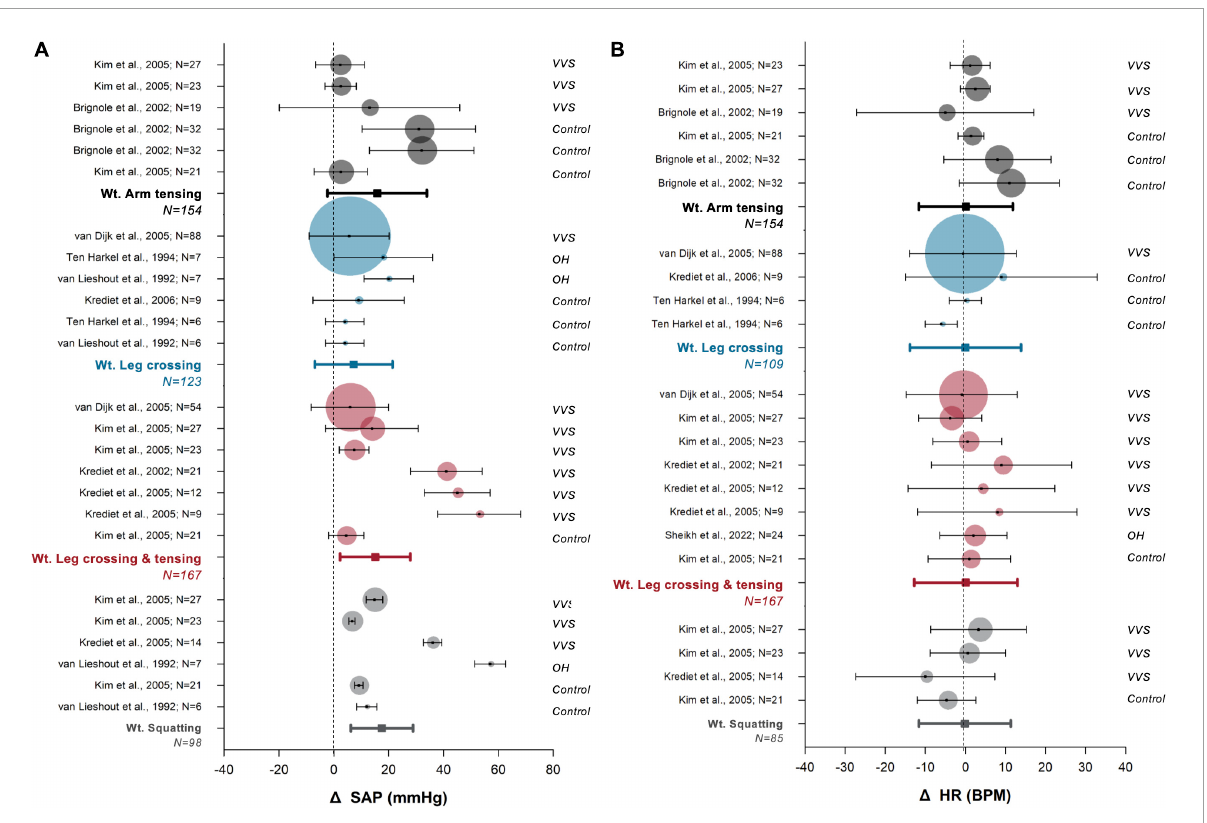
FIGURE4 Meta-analysis of cardiovascular responses to commonly prescribed counter pressure maneuvers. Responses of systolic arterial pressure [SAP, (A) ] and heart rate [HR, (B) ] are shown. The most highly studied counter pressure maneuvers were arm tensing (black), leg crossing (blue), leg crossing with muscle tensing (red), and squatting (gray). Data for each study are presented as the mean (circle) and standard deviation (whiskers), with the size of the circle proportional to the study sample size. Bolded whisker plots show the weighted (wt.) mean and standard deviation of group analyses. Vertical dotted lines indicate zero effect. The population considered is indicated to the right of each plot: vasovagal syncope (VVS), orthostatic hypotension (OH, included classical OH, and hypoadrenergic OH), and healthy controls